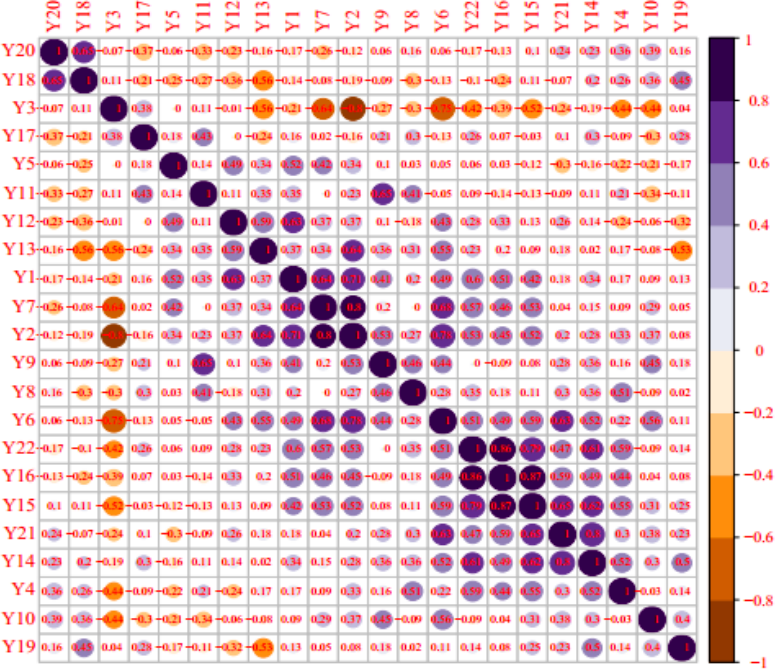
Figure 7. Heat map of Pearson’s correlation analysis for morphological traits in different popula- tions of M. aquatia in the Hyrcanian hotspot of Iran. Heat map representing Y1: plant height, Y2: plant width, Y3: plant length /width ratio, Y4: main stem diameter, Y5: tnternode length, Y6: